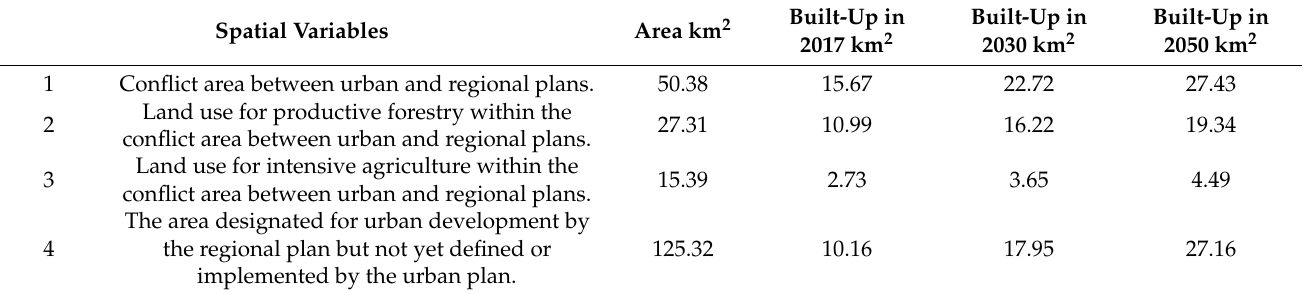
Table 3. Calculated area of spatial inconsistencies between urban and regional plans and the associated current and future built-up area in Abuja city.